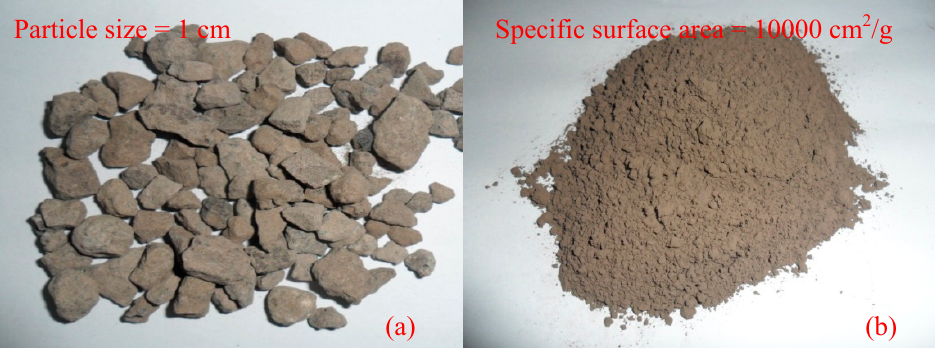
Figure 1. Appearance of BOFS before grinding ( a ) and after grinding ( b ).